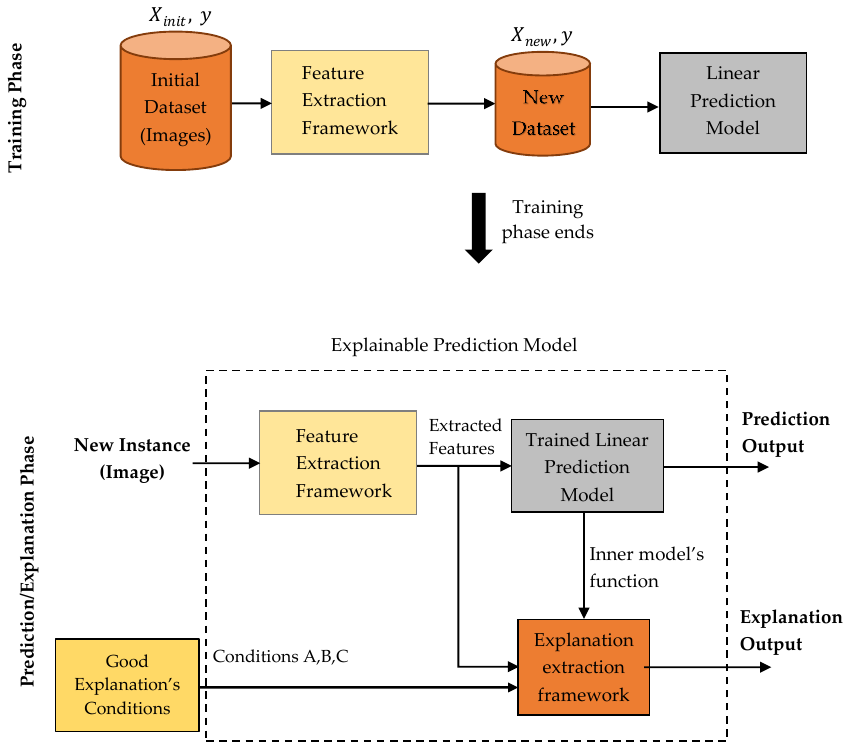
Figure 1. An abstract overview of our proposed explainable model.